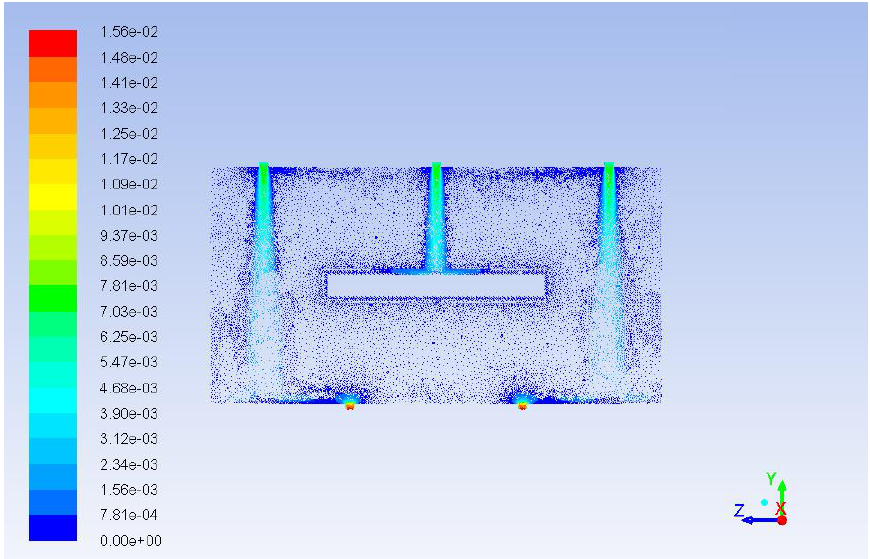
Figure 11. Path lines starting from inlets (The Figure is prepared with the outer face cut to show boundary surfaces and internal area at the same time).